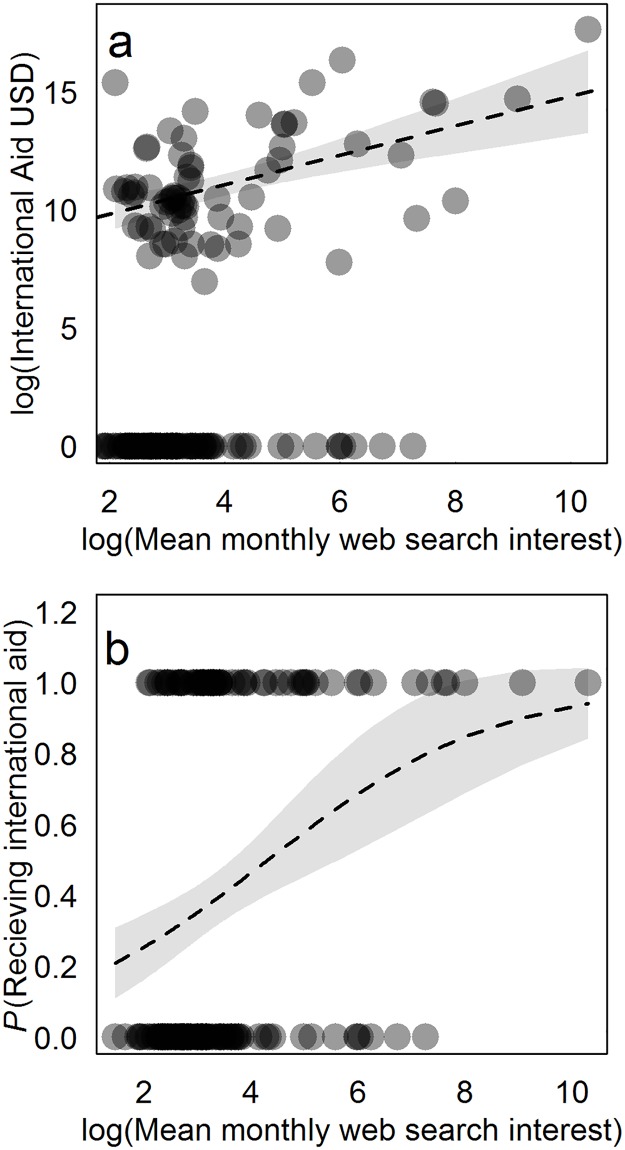
Higher online web search interest in endangered and critically endangered species of vertebrate is associated with greater financial investment in their conservation.a) The relationship between the average monthly web search interest in species between 2004 and 2014, and the amount of international aid invested in their protection (in US dollars) was quantified using a Gaussian GLM performed on log transformed (to reduce leverage) response and predictor variables. Species for which no financial investment was recorded (0 on the y axis) were not included in this analysis but were included in b. b) The relationship between the average monthly web search interest in species between 2004 and 2014, and the probability that they received international aid over the same time period, was quantified using a Binomial GLM performed on a log transformed (to reduce leverage) predictor variable. Values of 1 on the y axis indicate species that received aid, while values of 0 indicate those for which no aid was documented. The grey regions in both panels represent the 95% confidence intervals of the predicted relationships (broken lines). Data are presented for 173 species of critically endangered and endangered vertebrate that Google Trends returned web search interest data for. Aid data were downloaded from the Aiddata database (see Methods for details) and are given in S9 Table.